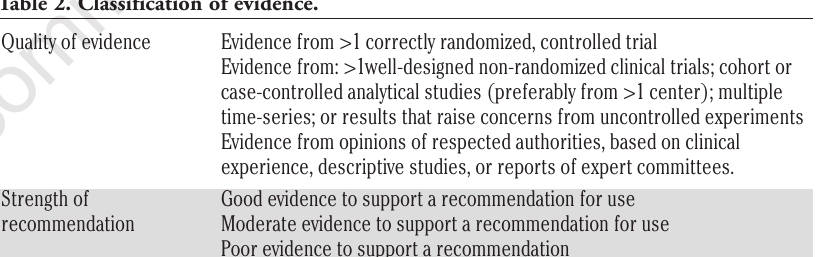
Table 2. Classification of evidence.